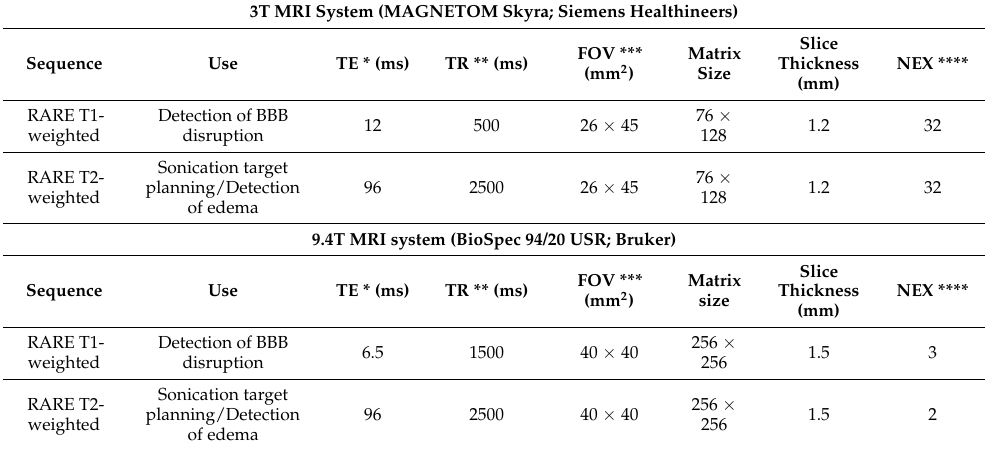
Table 2. MR imaging